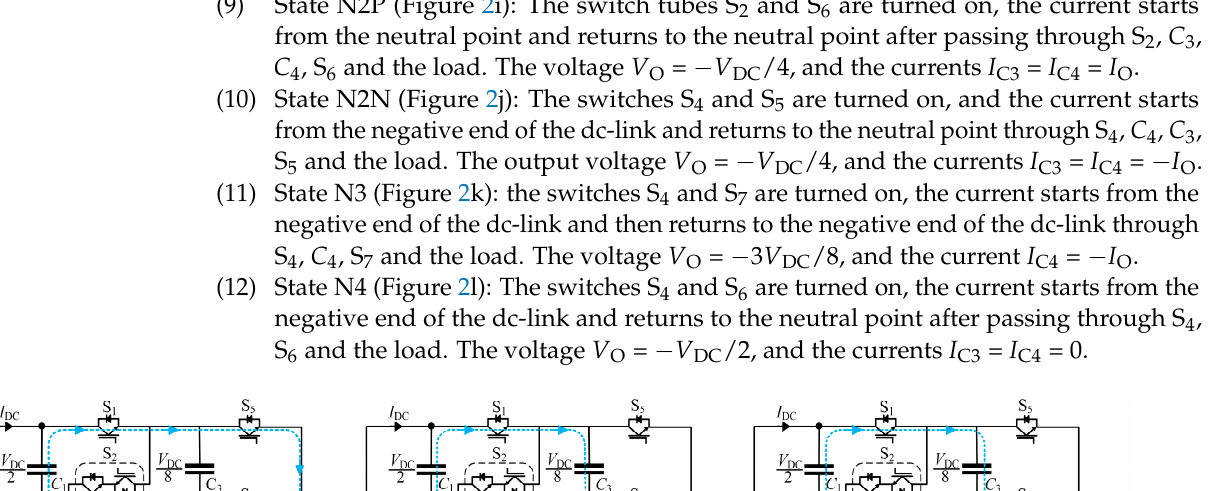
Table 1. Switching states of the proposed 9-level converter.